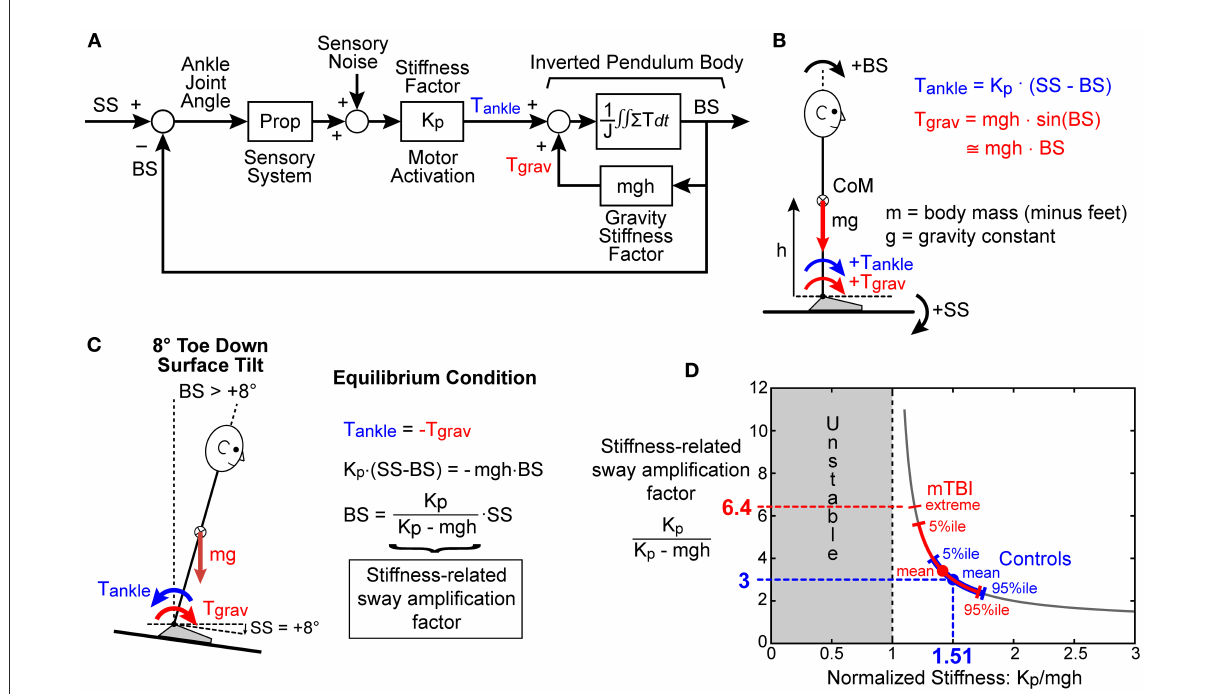
FIGURE3 Simplified model used to explain the potential for the motor activation stiffness factor to determine the sensitivity to external and internal balance perturbations. (A) A greatly simplified feedback control model where proprioception accurately senses ankle joint angle, which is the difference between the stance surface ( SS ) angle and body sway ( BS ) angle, and then generates ankle torque, T ankle , in proportion to this difference with the proportional stiffness factor K p . Lean of the body away from vertical generates a destabilizing torque due to gravity, T grav , proportional to BS with a “gravity stiffness” proportional factor mgh (mass x gravity constant x height of body center-of-mass). (B) The various biomechanical factors and the positive directions of SS , BS , T ankle , and T grav are defined. (C) When the stance surface is rotated to a non-horizontal orientation, the balance control system will cause the body to move to a new equilibrium orientation where T ankle is equal in magnitude but opposite in direction to T grav . The BS equilibrium angle is proportional to SS but is always greater than SS with the proportional factor of K p /( K p - mgh ) defined as the “Stiffness-related sway amplification factor.” (D) Graph showing the hyperbolic relationship between K p /( K p - mgh ) and normalized stiffness factor K p / mgh . The mean values of K p / mgh and the range of values for control (blue) and mTBI subjects (red) measured in the SS/EC condition are overlaid on the hyperbolic curve and show generally lower K p / mgh and higher K p /( K p - mgh ) values for mTBI subjects resulting in increased sensitivity to balance